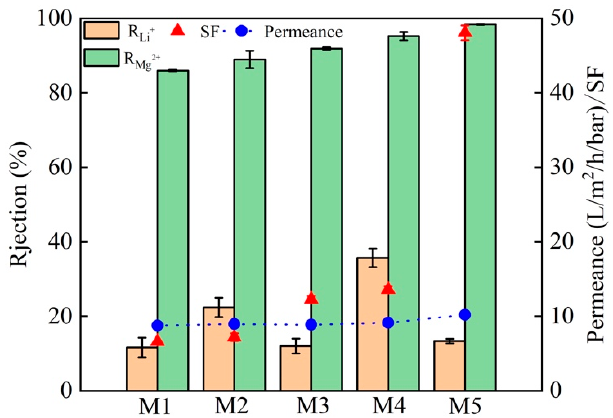
Figure 10. Separation performance and permeance of M1, M2, M3, M4, and M5 membranes in salt solution with a Mg 2+ /Li + ratio of 20.